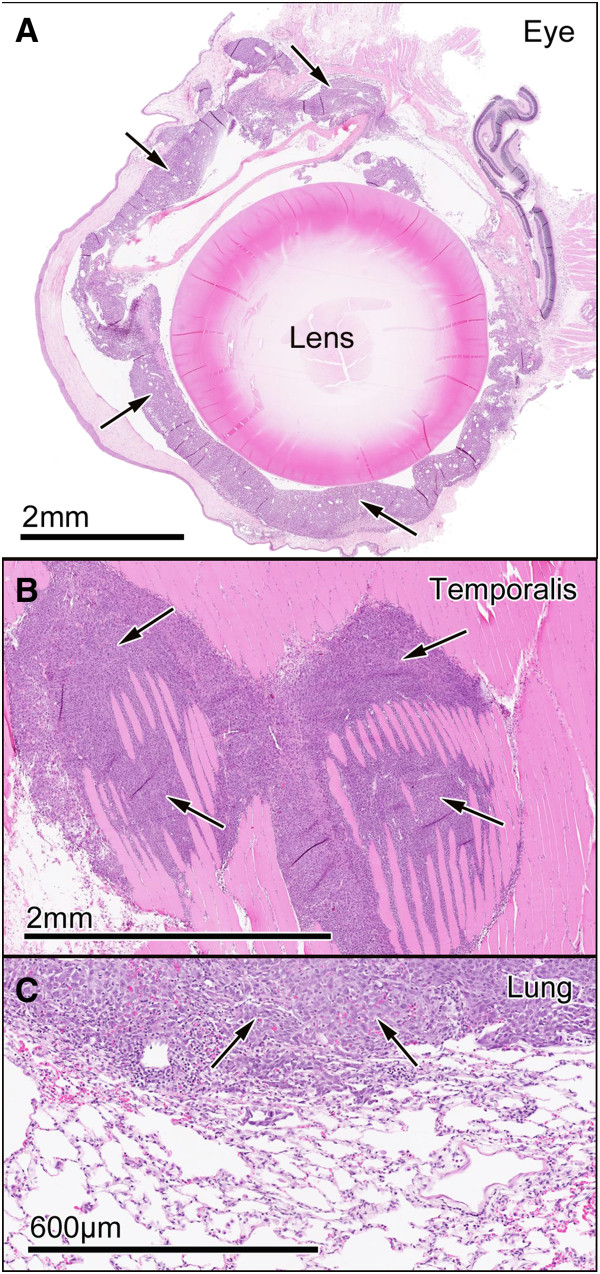
Extracranial tumour growth. (A) CRCTU Walker 256 tumour growth (arrows) in the eye 9 days following internal carotid artery injection stained with haematoxylin and eosin. (B) CRCTU Walker 256 tumour growth (arrows) invading the temporalis muscle 9 days post internal carotid artery injection, stained with haematoxylin and eosin. (C) Lung section stained with haematoxylin and eosin, showing a large tumour mass (arrows) 9 days following CRCTU Walker 256 cells carotid injection.